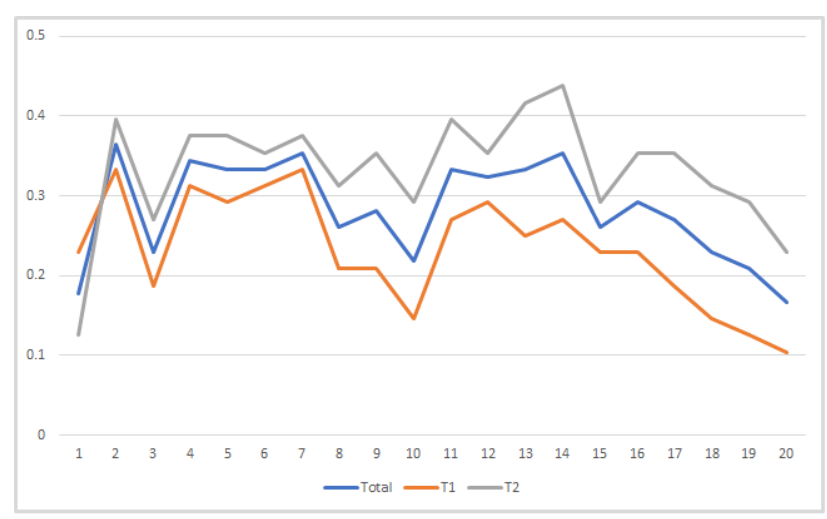
Figure 5. The Proportion of Aggressive Play over Rounds.